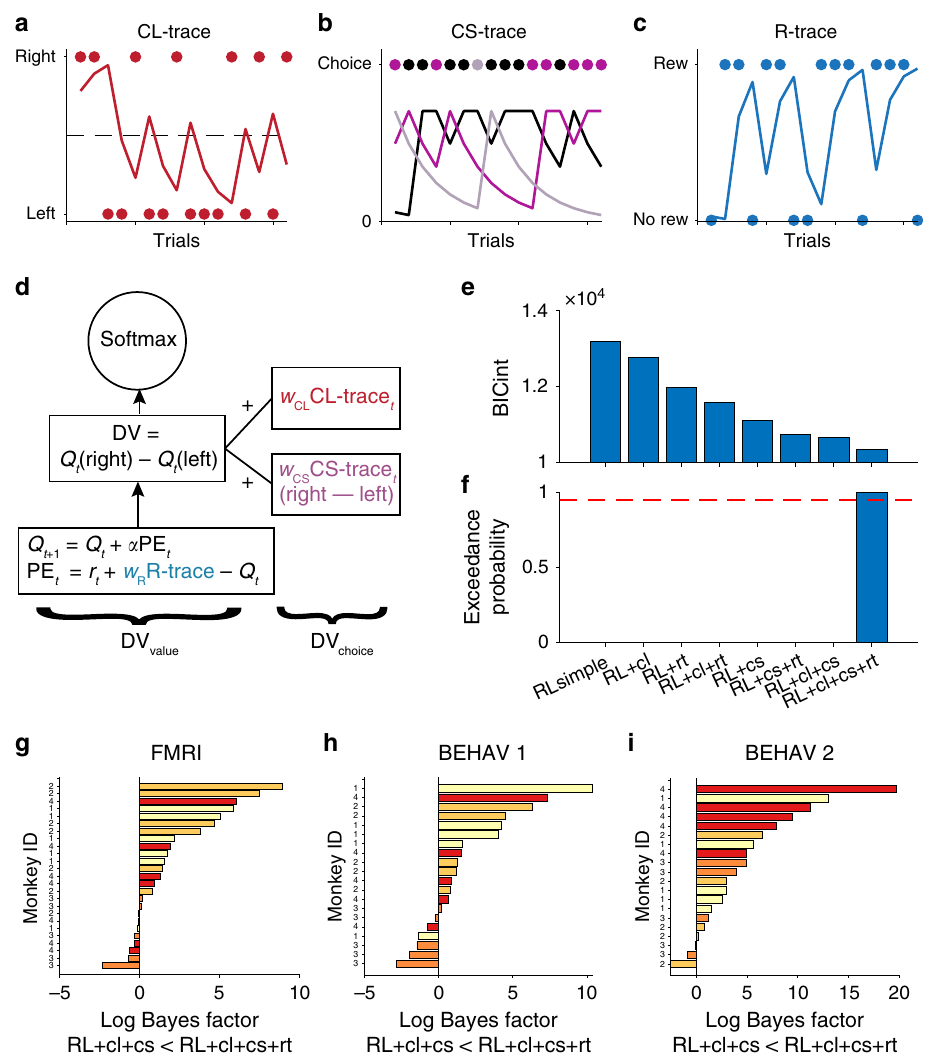
Fig. 2 RL modeling of choice and reward traces. Illustration of choice-location trace (CL-trace, a ), choice stimulus traces (CS-trace, different colors indicate different choice stimuli, b ) and reward trace (R-trace, c ). d Model architecture. Black colors indicate components used by all models. The other colors refer to choice and reward traces as illustrated in panels a – c . Note that CL-trace and CS-trace effects are added directly to the DV of the model, whereas R-trace affects the prediction error calculation. e Nested model comparison using BICint (lower values indicate better fi t). The full model including R-trace explains the data best. x-labels are the same for panels e and f . f Exceedance probability also favors the full model among our set of candidate models. The dashed red line indicates an exceedance probability of 0.95. g – i Experiment speci fi c comparisons of Bayes factors between full model and second-best model. Bars are individual sessions and direction of the bars (left vs right) indicate better model fi t in favor of the full (going to the right) compared to the second-best model (going to the left). Colors indicate individual monkeys. ( n = 65 sessions). Source data are provided as Source Data fi